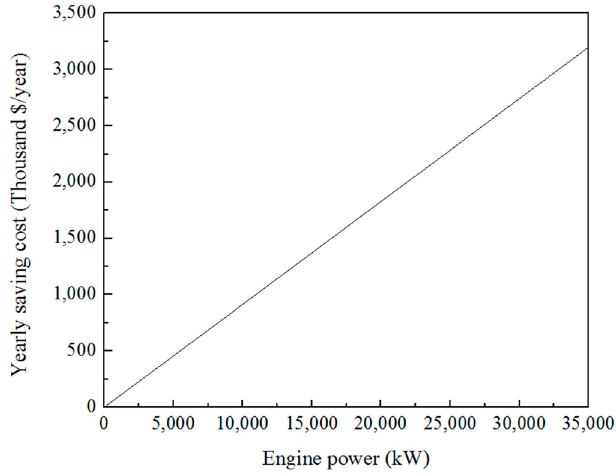
Figure 13. Relationship between yearly saving cost and engine power with a scrubber installed.